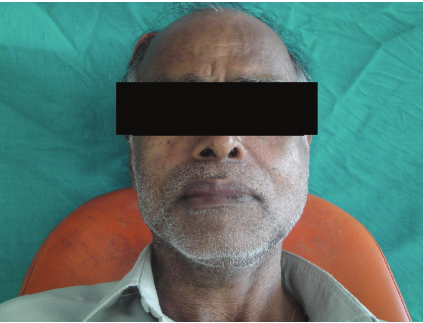
Figure 1: Extraoral examination revealed mild diffuse swelling of left lower face.